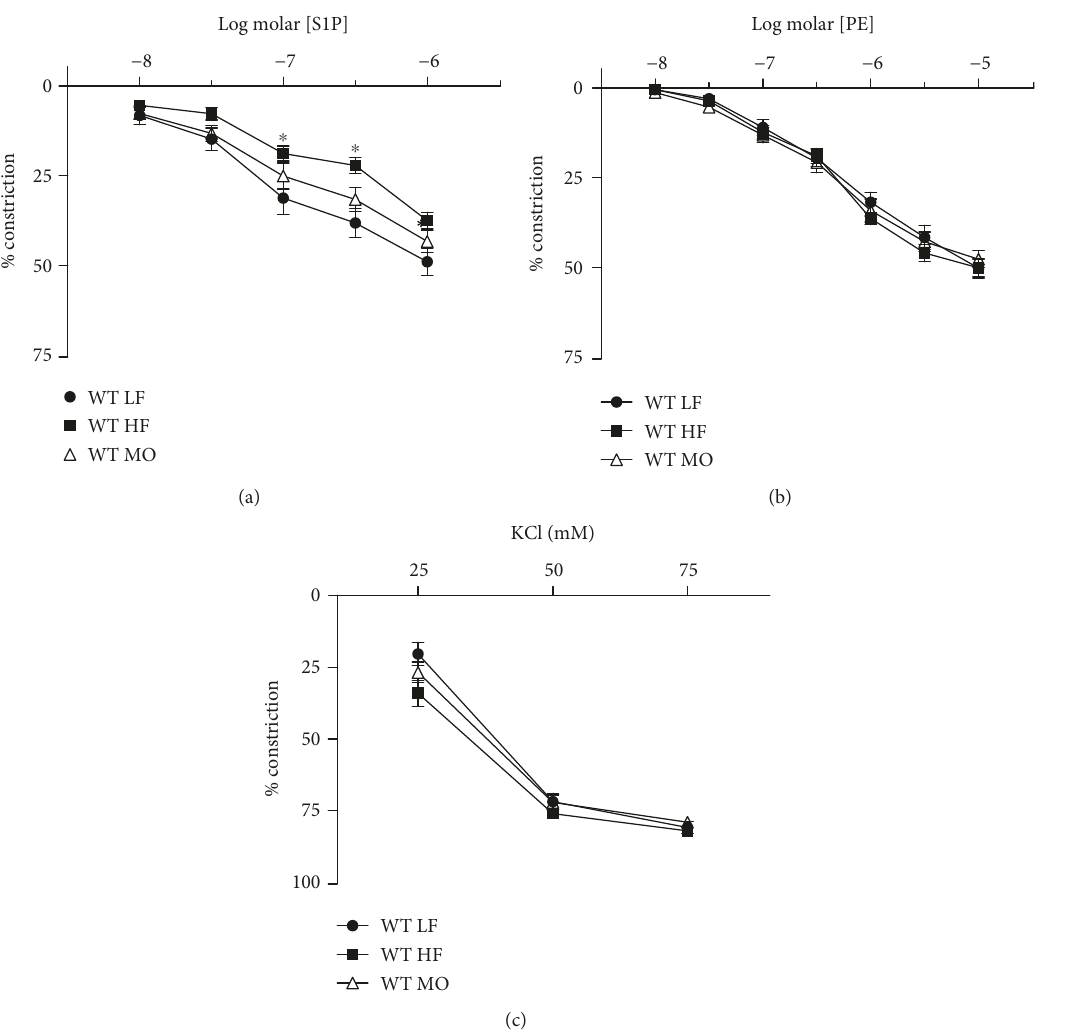
Figure 2: Constriction of gracilis arteries from WT mice on LF, HF, and MO diets to S1P (a), PE (b), and KCl (c). Mean ± SEM , n = 12 ‐ 16 per group, ∗ p < 0 05 vs. LF. Two-way repeated-measures ANOVA followed by Sidak ’ s multiple comparison